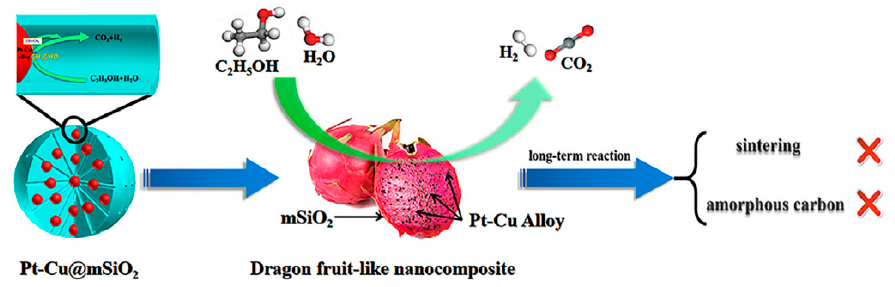
Figure 2. Schematic representation of the use in ESR of dragon fruit-like nanocomposite